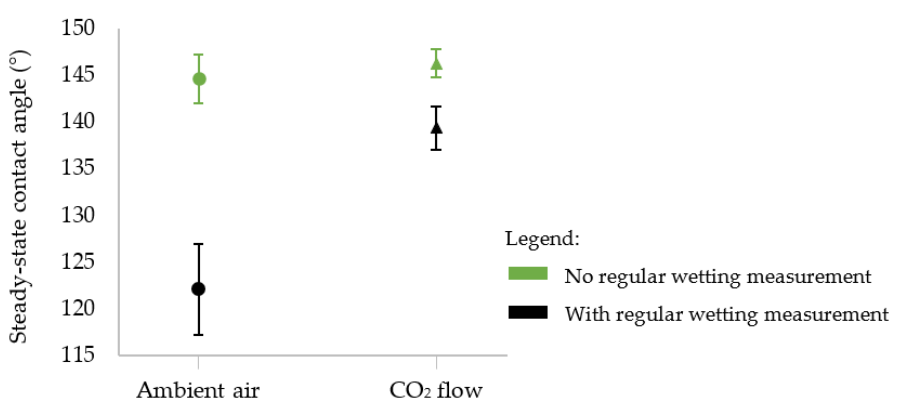
Figure 15. Steady-state contact angles of samples textured in ambient air or under a CO 2 flow for which the square pillars’ top was not irradiated, and for which regular wetting measurements were (in black) or were not (in green) conducted over time.